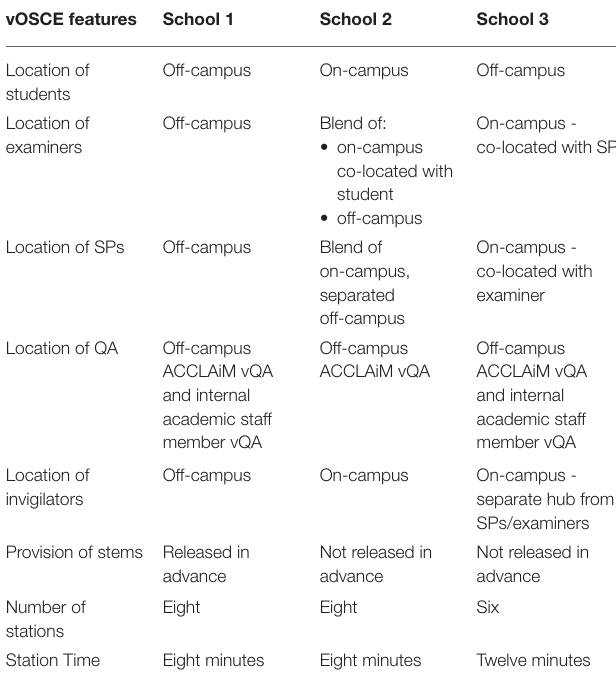
TABLE 1 | vOSCE designs used by the participating medical schools in